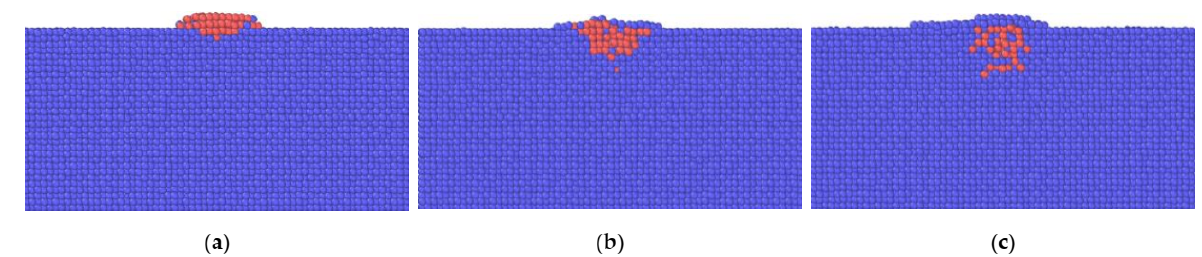
Figure 3. Morphology snapshots (side views of the center section along x–z plane) of Cluster 0 and substrate after impacting at three different V z , 0 in Model 1: ( a ) V z , 0 = 300 m/s, ( b ) V z , 0 = 600 m/s and ( c ) V z , 0 = 900 m/s. In all cases, V x , 0 = 0 m/s.